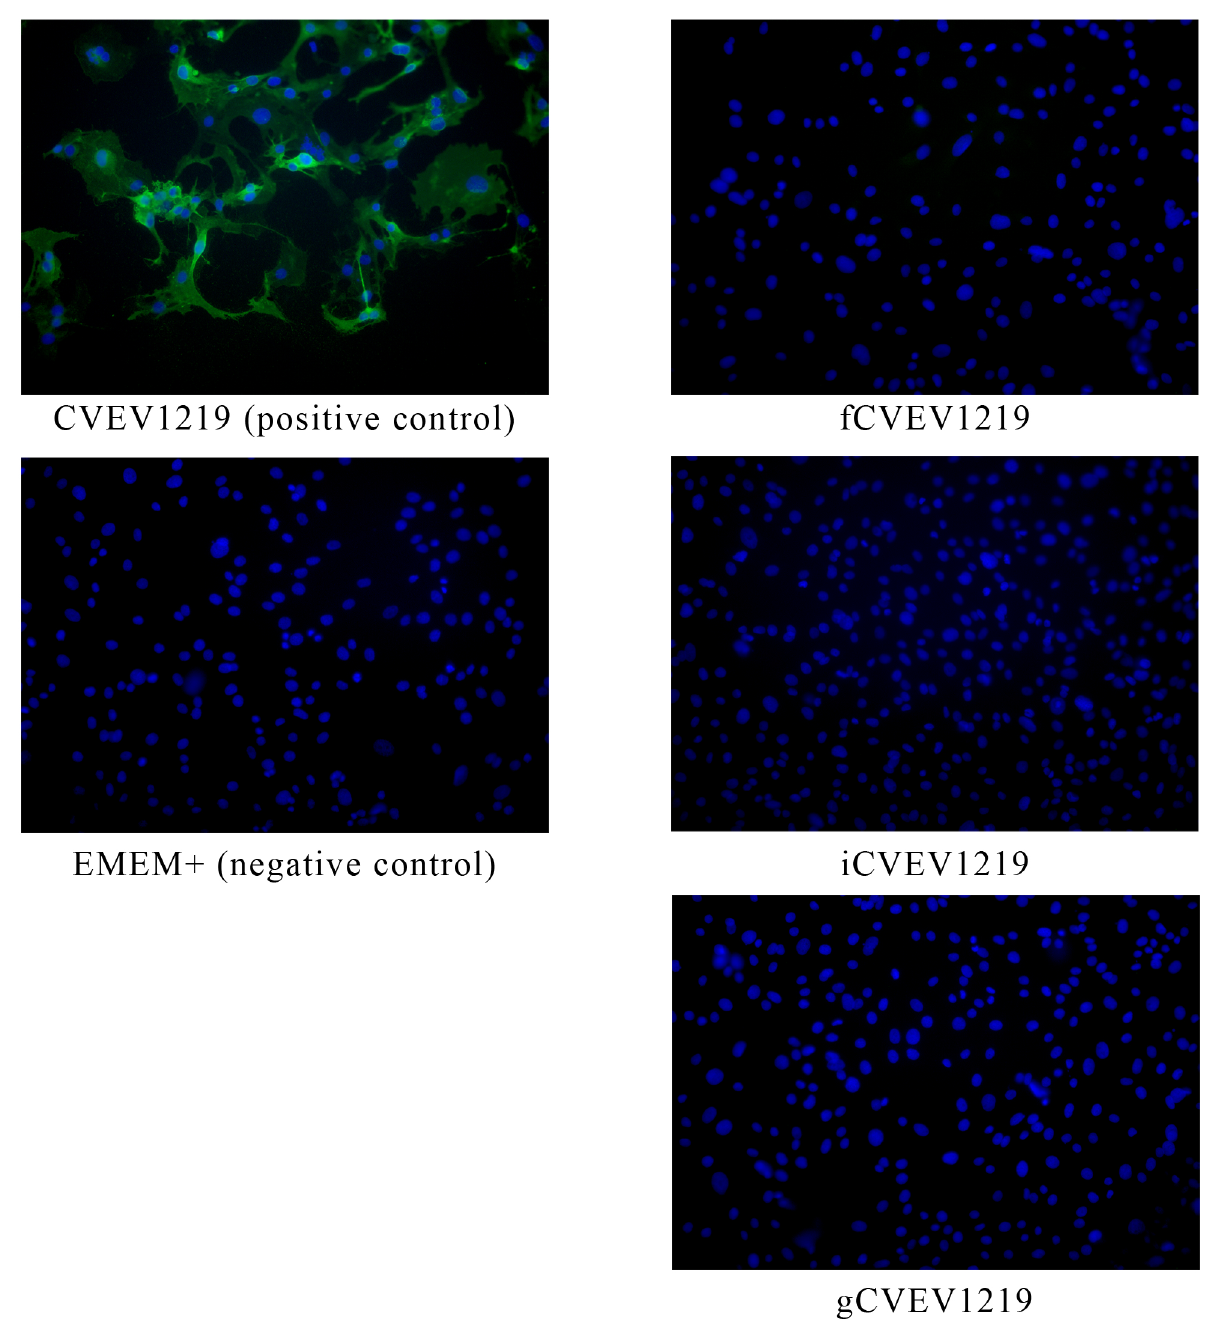
Figure 2. Immunofluorescent detection of EEEV antigen. Inactivated samples were passed five times on BHK-21 cells. The supernatant from the 5 th pass was evaluated by immunofluorescent assay using a polyclonal EEEV Ab to ensure no residual infectivity.